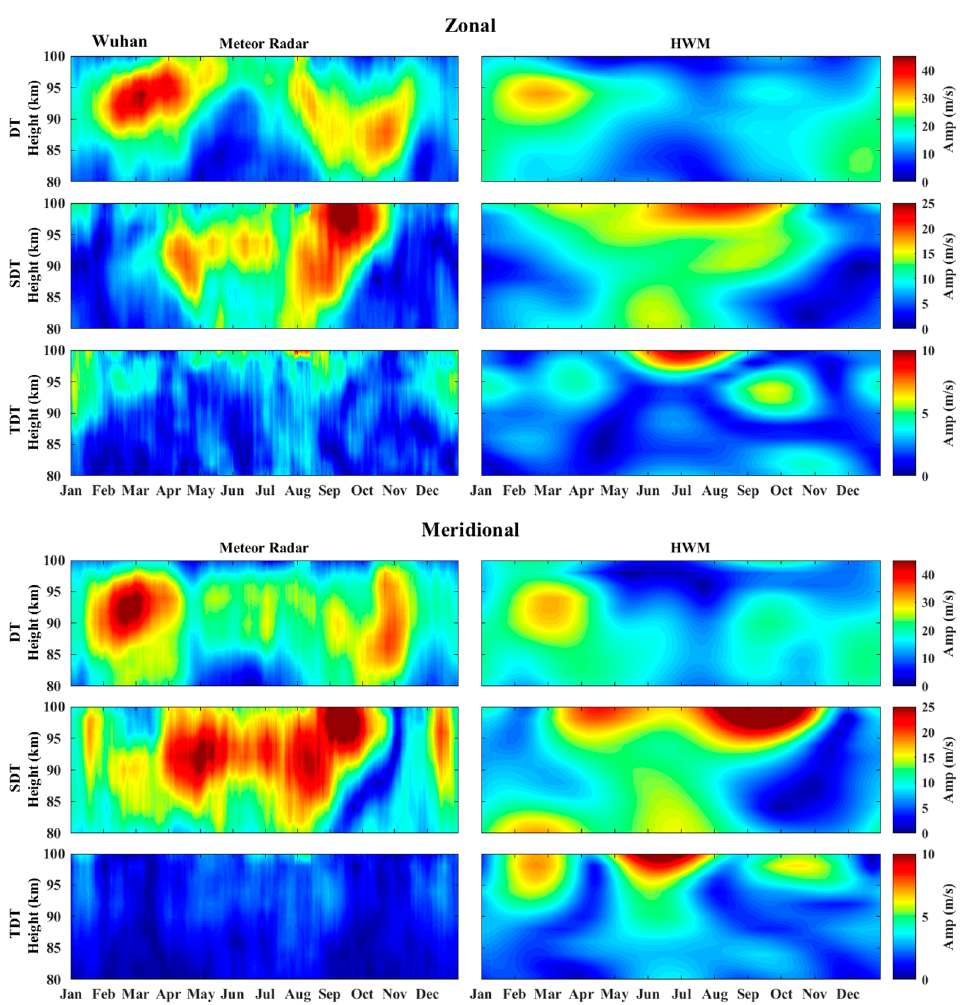
Figure 6. Diurnal (DT), semidiurnal (SDT), terdiurnal (TDT) tidal amplitude obtained from Wuhan meteor radar measurements ( left column ) and HWM14 ( right column ).